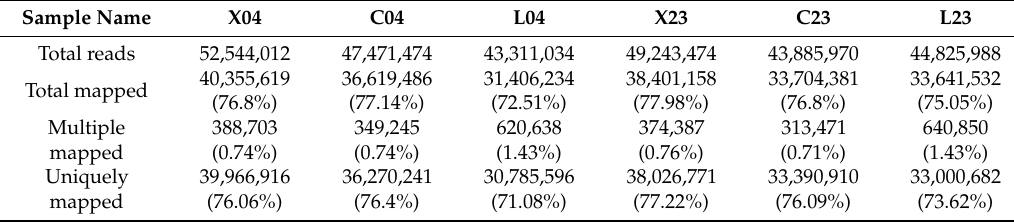
Table 1. Alignment results of the clean reads to the reference genome.